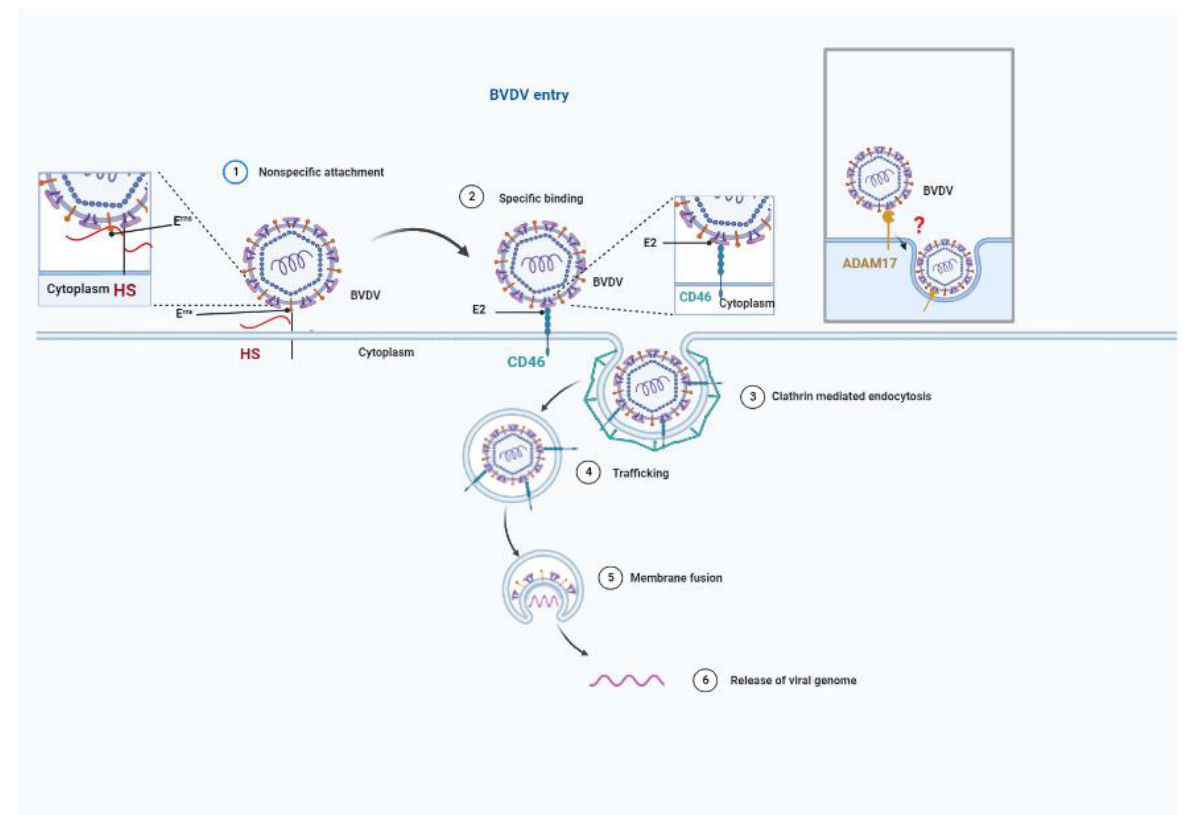
Figure 3. The entry route of BVDV. The entry of BVDV initiates the binding to some cellular membrane proteins, such as HS, CD46 and ADAM17. Of these, HS is thought to be involved in viral non-specific attachment and CD46 is considered to be a crucial receptor for BVDV entry. After viral attachment and binding, BVDV is trafficked by endosomes through clathrin-mediated endocytosis. At low pH, endosomes are acidified to trigger membrane fusion, which unravels the envelope and releases the viral genome into the cytoplasm. Table 1. Cellular proteins that mediate BVDV